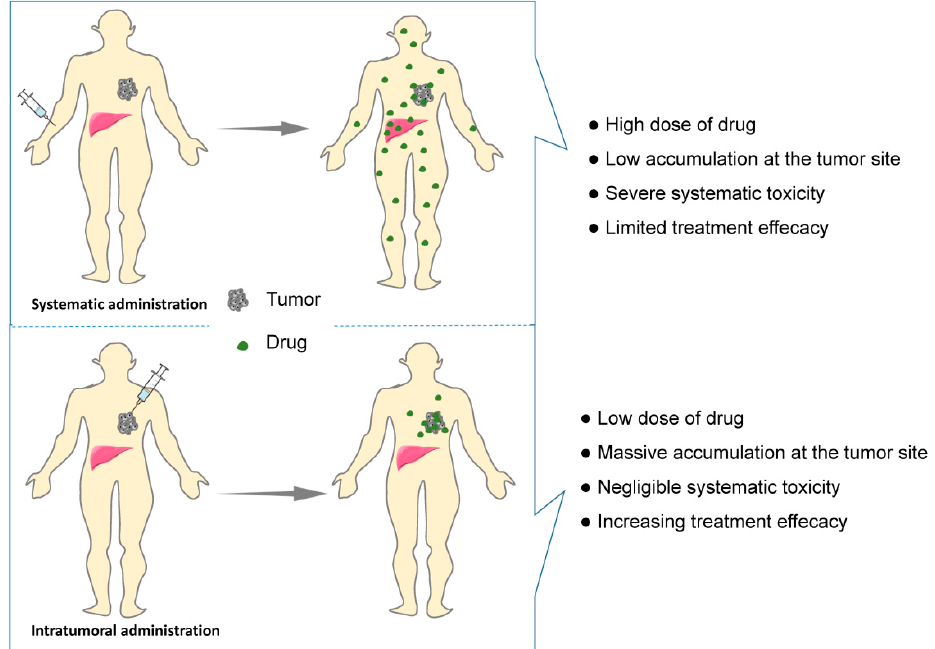
Figure 2. Schematic showing systematic vs. intratumoral administration of anticancer drugs. Compar- ing with systematic administration, drug biodistribution is localized to the tumor site by intratumoral administration, resulting in lower drug dose requirement and less systematic adverse effect and higher treatment efficacy.